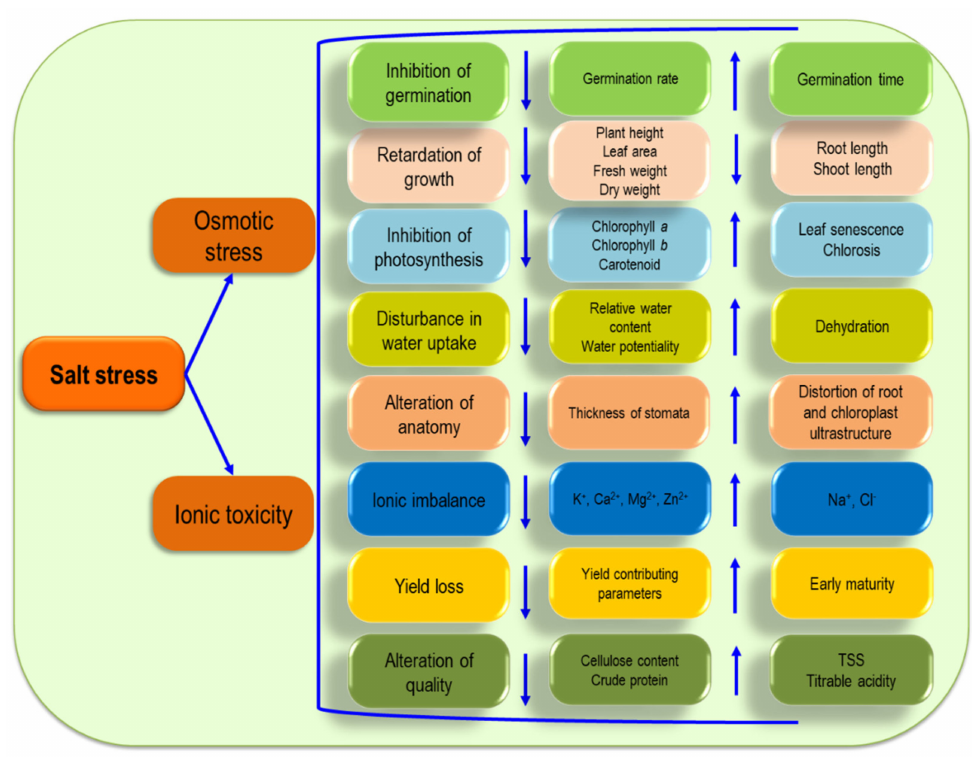
Figure 5. An overview of salt stress-induced changes in plants. TSS—total soluble